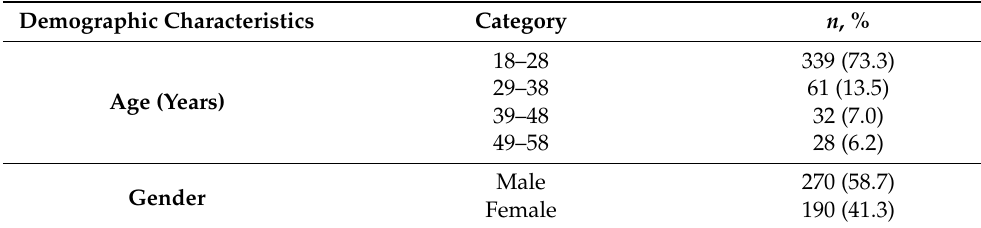
Table 1. Demographic characteristics and general information of